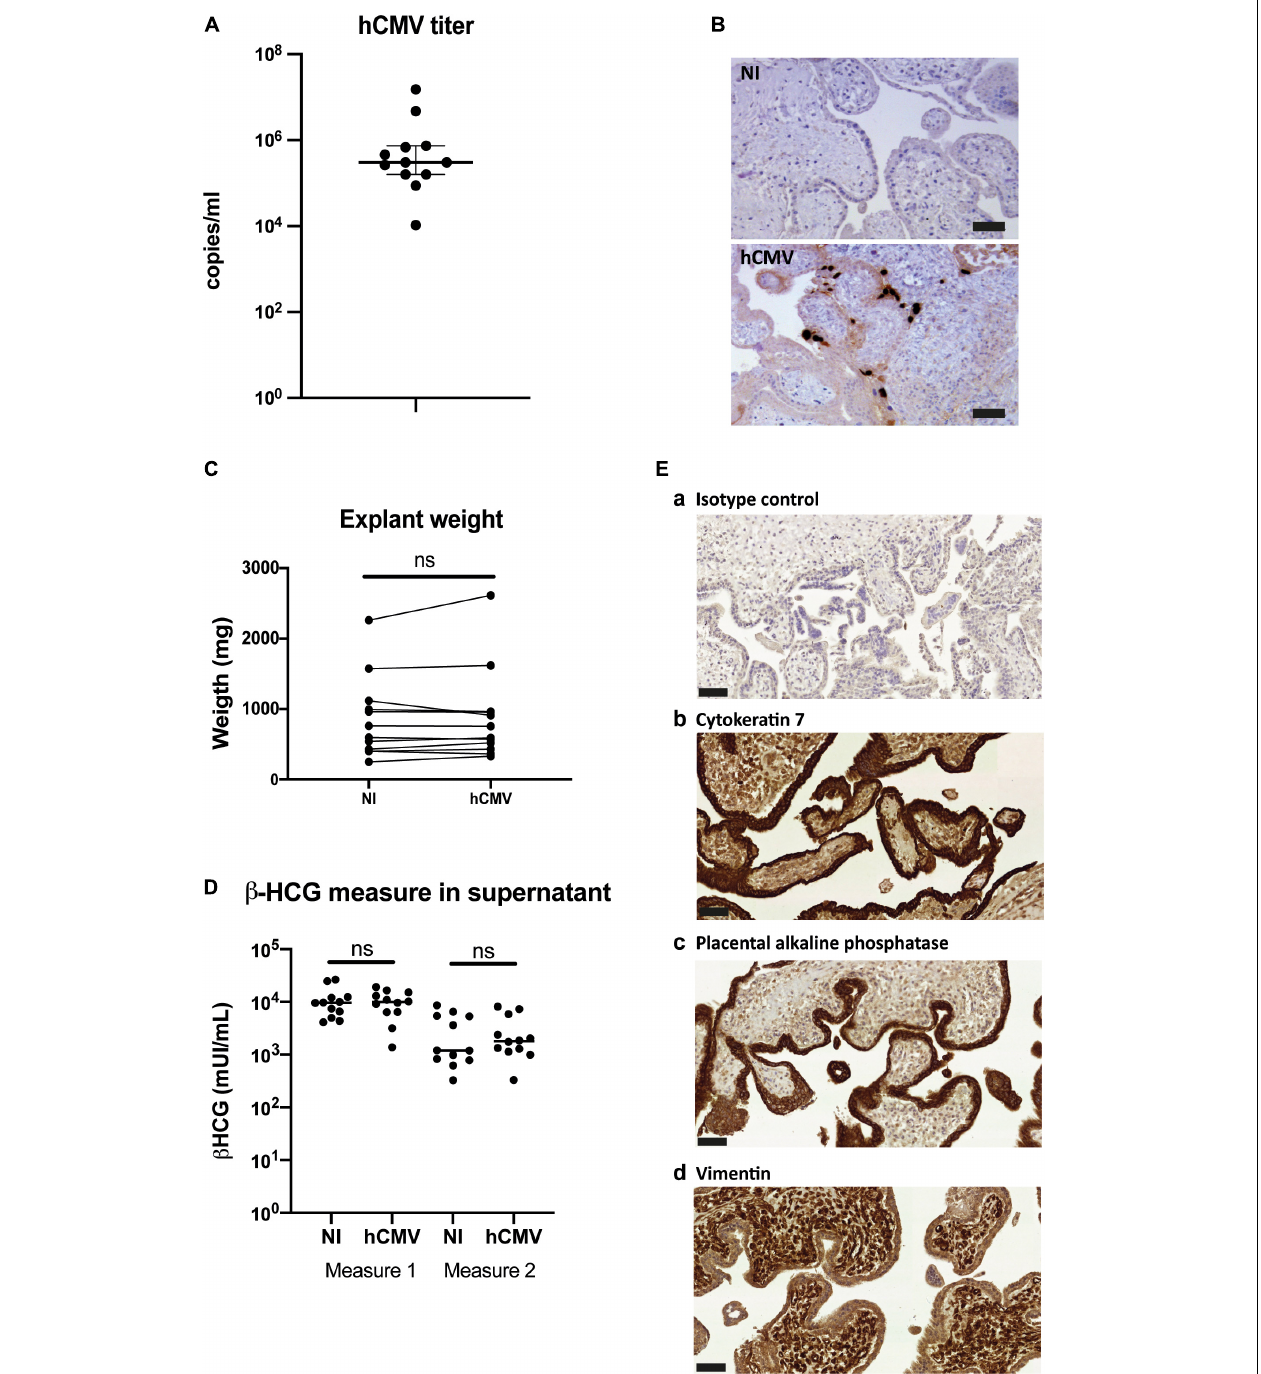
FIGURE 5 | Impact of hCMV infection on placental histocultures. (A) Titration of hCMV genome copies released in histoculture supernatant at day 11. On the graph is indicated the median with 95% CI. n = 12 independent experiments. (B) Representative examples of immuno-histochemistry performed against hCMV IE antigen at day 14 on sections of placental villi, counterstained with hematoxylin. Scale bar = 50 µ m. (C) Comparison of the explant weight at the end-point of the placental histocultures, performed for twelve independent experiments. Each of the placental explants were pooled per condition and weighted (NI = non-infected). ns, non-significant ( p = 0.3804 ) by Wilcoxon paired test. (D) Comparison of the β -HCG secretion in explant supernatants was performed between non-infected (NI) versus hCMV-infected placenta, measured with the same timeline as presented in Figure 1A . ns, non-significant ( p = 0.9697 for measure 1; p = 0.5693 for measure 2) by Wilcoxon paired test. n = 12 independent experiments. (E) Cross sections of immunohistochemistry and hematoxylin staining of hCMV infected placental villi from histoculture at day 14, observed by bright field microscope. a- Isotype control; b- Cytokeratin 7; c- PLAP; d- Vimentin. Image representative from at least three independent experiments. Scale bar = 50 µ